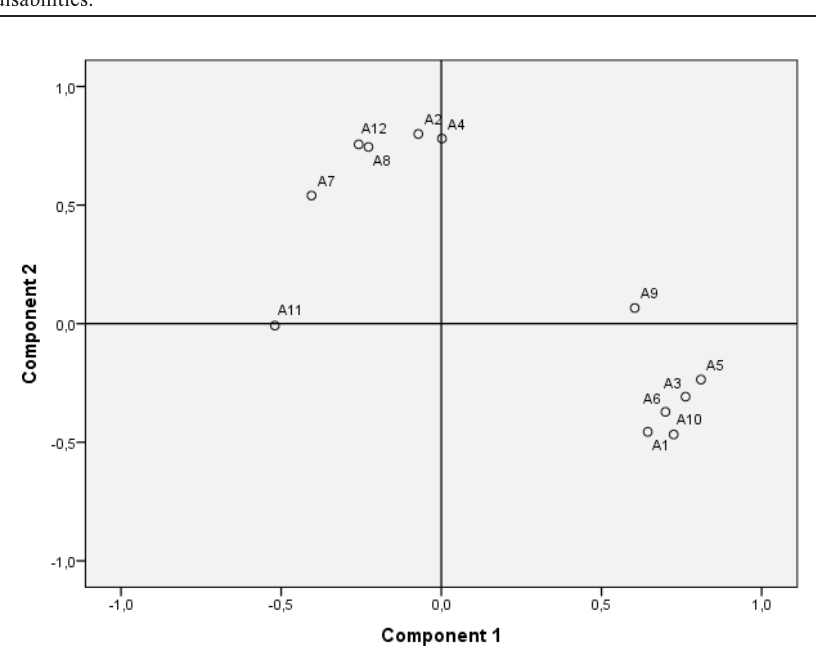
Figure 1. Factor loading plot for the rotated PCA solution. A1–A12 are items of ATIPDPE-R-PL according to Table